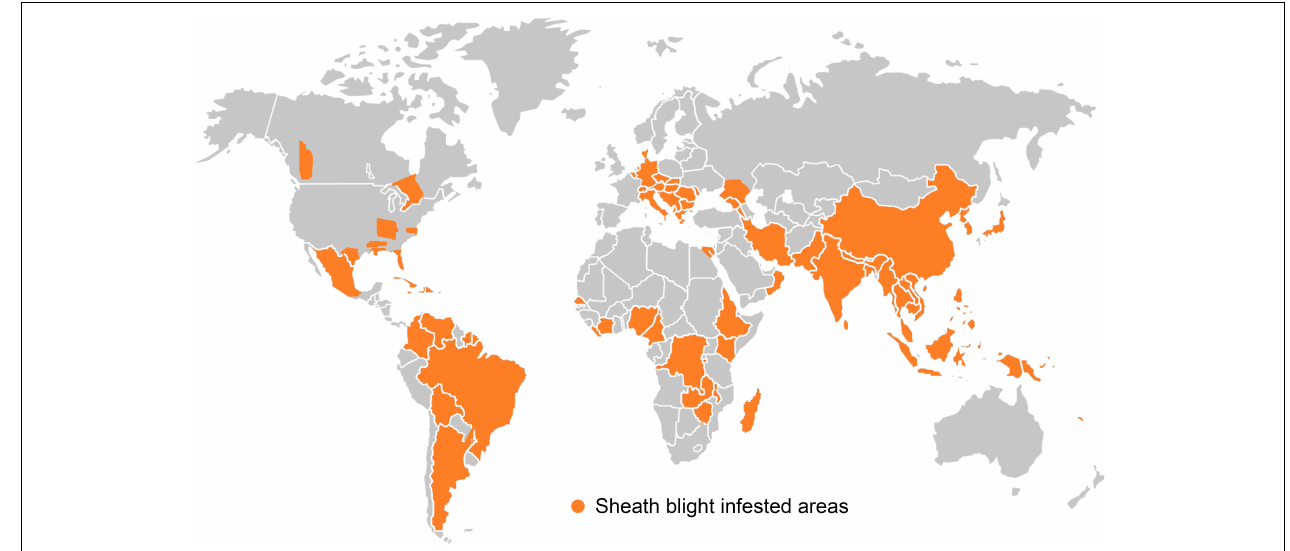
FIGURE 3 | Geographical distribution of sheath blight disease occurrence in different countries of the